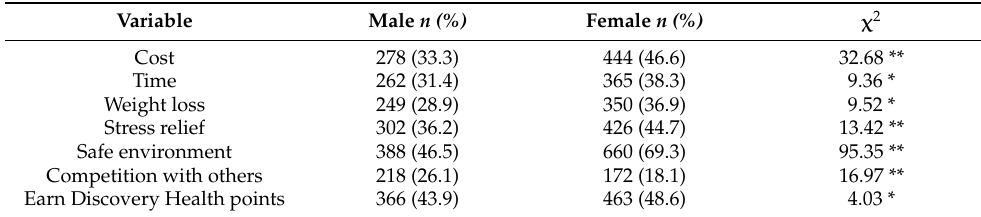
Table 2. Participant motivation to participate in parkrun according to